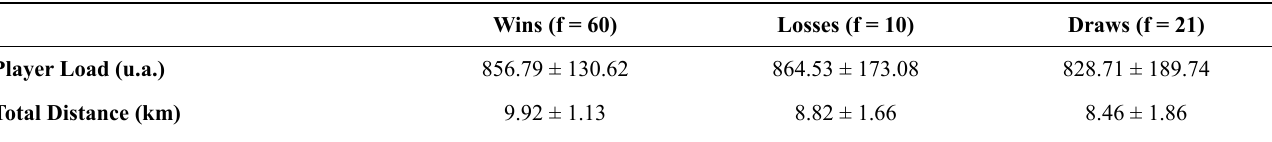
Table 2. - Comparison of external and internal load and recovery by the result. Wins (f = 60) Losses (f = 10) Draws (f = 21) Player Load